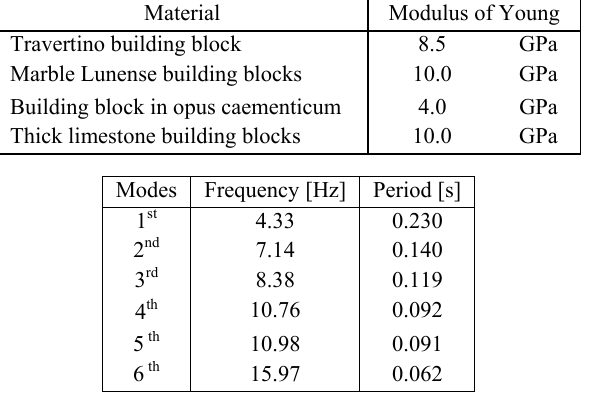
Table 4. Modal analysis results, Reference Case The first three modal shapes respectively show transversal, longitudinal and rotation motion of the top side. The upper modal shapes involve deformations in the walls of the Attic.In Fig.13 the 3rd and 5th are described as examples